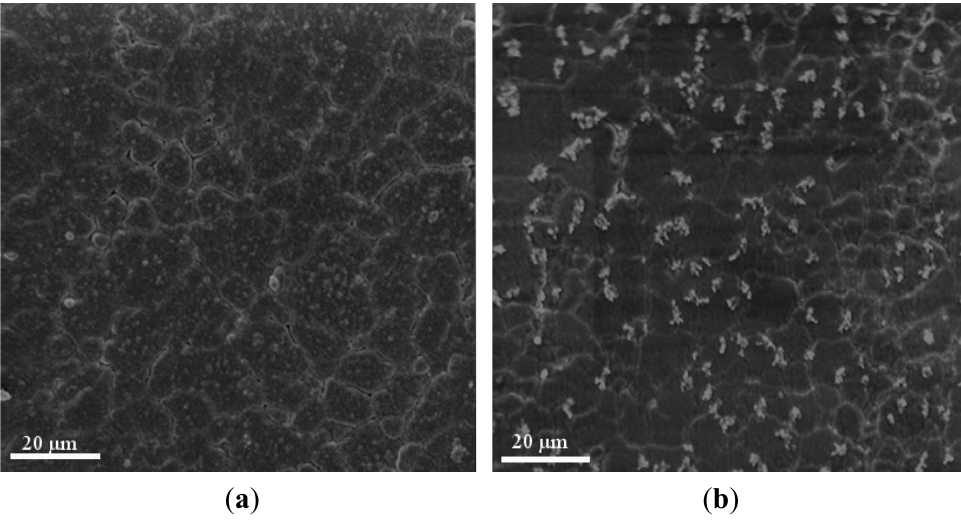
Figure 4. SEM micrographs of T3, ( a ) as deposited coating; and ( b ) after being under water for 2